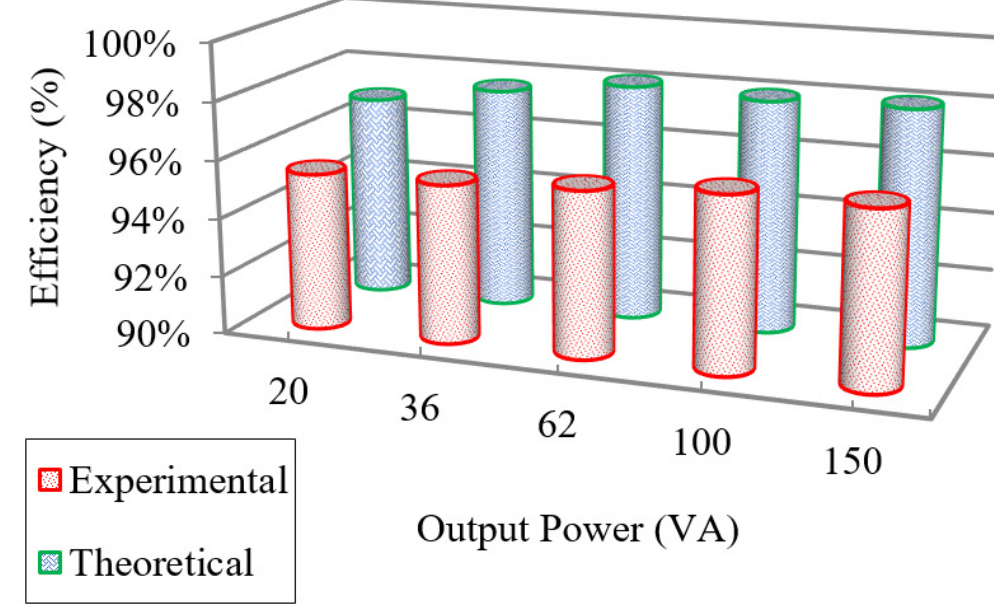
Figure 17. Experimental and theoretical e ffi ciency analysis at 8 kHz switching